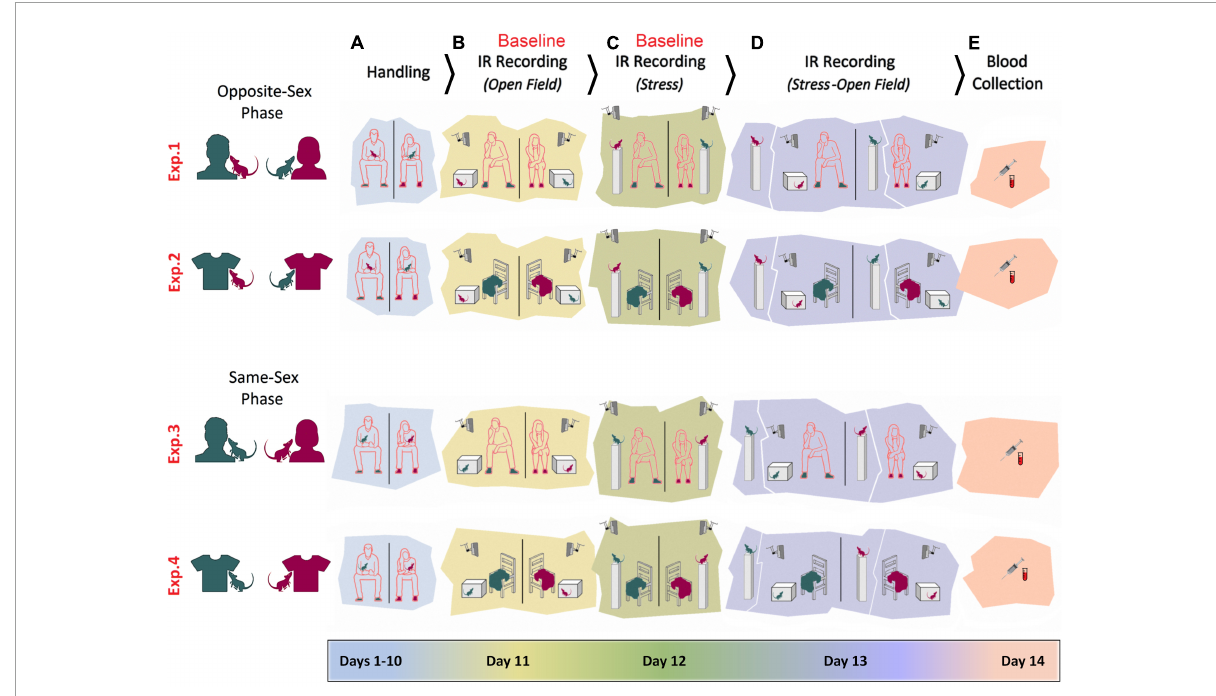
FIGURE1 Experimental design. Female and male adult rats were exposed to female and male experimenters in four distinct experiments (Exp1–4). In Experiments 1–2, rats were exposed to opposite-sex experimenters or their T-shirts, whereas rats in the Experiments 3–4 were required to be handled and/or tested by same-sex experimenters. In all experiments animals were manipulated for handling (A) , pre-stress open field testing (B) , stress (C) , stress and post-stress open field testing (D) , and blood sampling (E) . Rats’ thermal responses to the experimental procedures were recorded by an infrared (IR) thermographic camera in the presence or absence of the